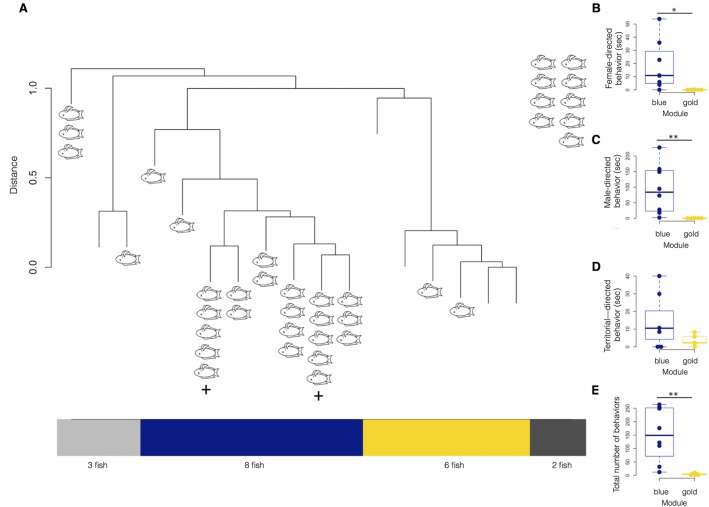
Results of unsupervised clustering of the fish by the number of incidents of each behavior performed during the first 15 min of Day 1. (A) The fish cluster into two proper modules, ‘dark blue’ (n=8, six escalating aggressive, two stable aggressive) and ‘gold’ (n=6, all stable aggressive). Each branch represents one fish (n=19). Distance between any two animals is defined as 1 minus the correlations between all their behaviors. Two fish performed 0 behaviors on Day 1, preventing correlations from being computed (both escalating aggressive, shown in dark gray to right), while three fish were unassigned to a module (two stable, one escalating, shown in light gray). Module assignments were significantly similar to later stable/escalating aggressive classification (P=0.017, chi squared). (B-E) There are significant differences between the ‘dark blue’ and ‘gold’ module in time spent performing female-directed behaviors (P=0.0072, Mann–Whitney) and male-directed behaviors (P=0.0019), as well as in the total number of behaviors (P=0.0025). There was no significant difference in time spent performing neutral/territorial behaviors (P=0.19), although it is worth noting that fish in the ‘gold’ module tended to spend more time performing these behaviors than performing social behaviors.